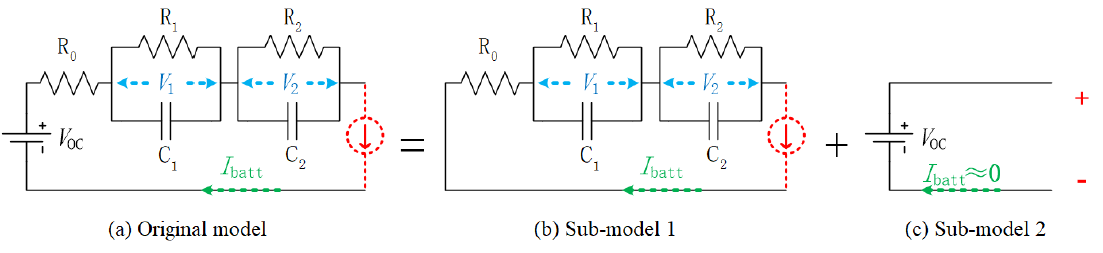
Figure 5. Battery ECM decomposition according to the superposition